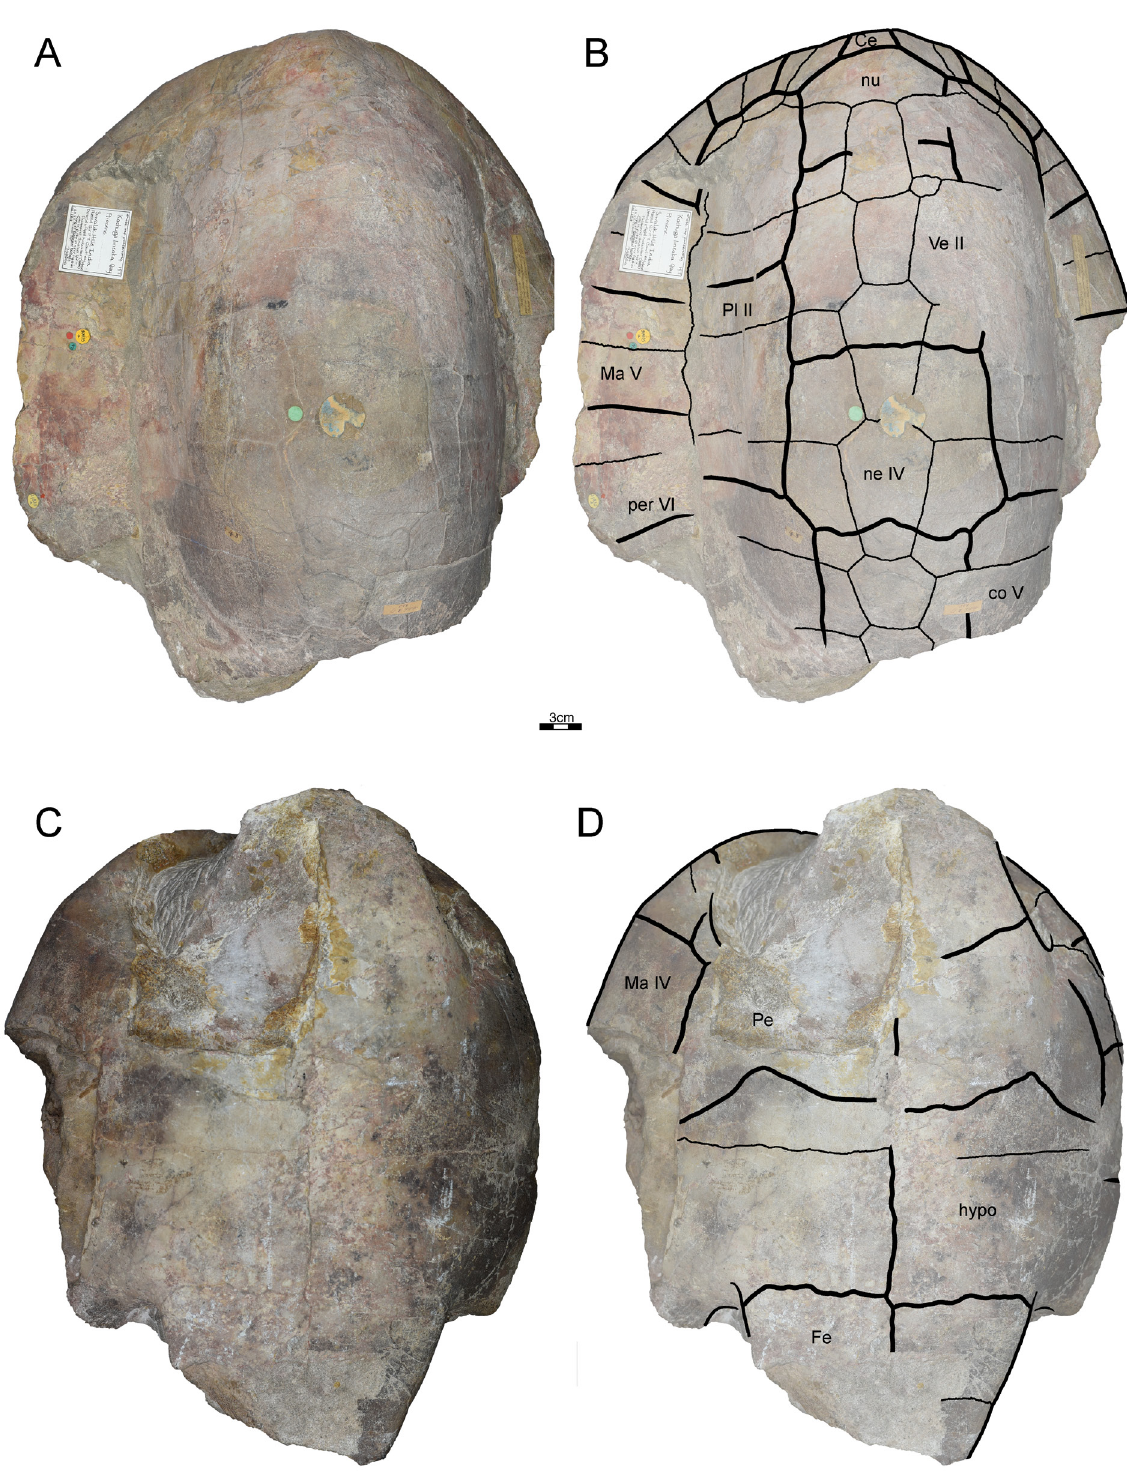
Fig. 12. BMNH 39835a, holotype of Batagur bakeri Lydekker, 1885, here identified as synonym of Batagur kachuga (Gray, 1831). A . Photograph of carapace. B . Illustration of carapace. C . Photograph of plastron. D . Illustration of plastron. Scale bar: 3